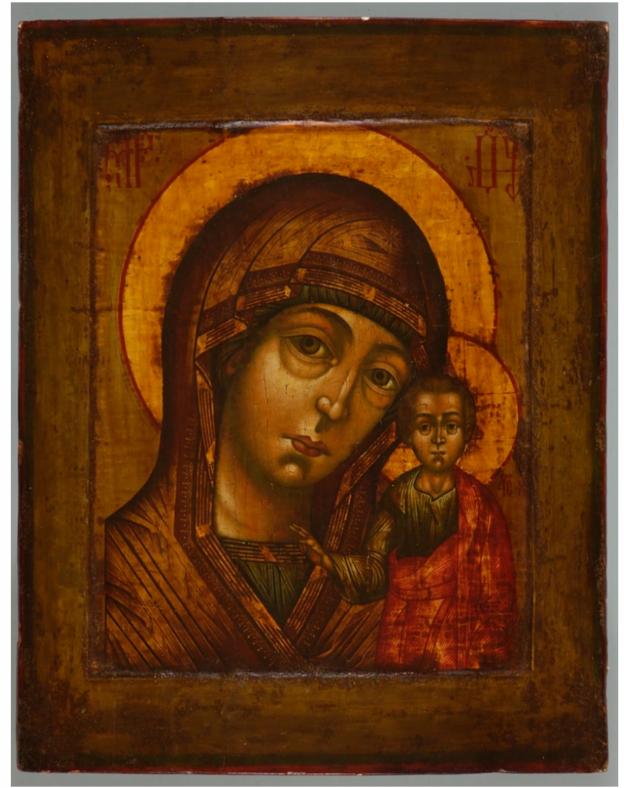
Figure 5. Mother of God of Kazan, Northern Russia, workshop of the Old Believers, beginning of 18th c., tempera on wood, 36.3 × 28.7 cm, National Museum in Warsaw, photo: Zbigniew Doli´nski.